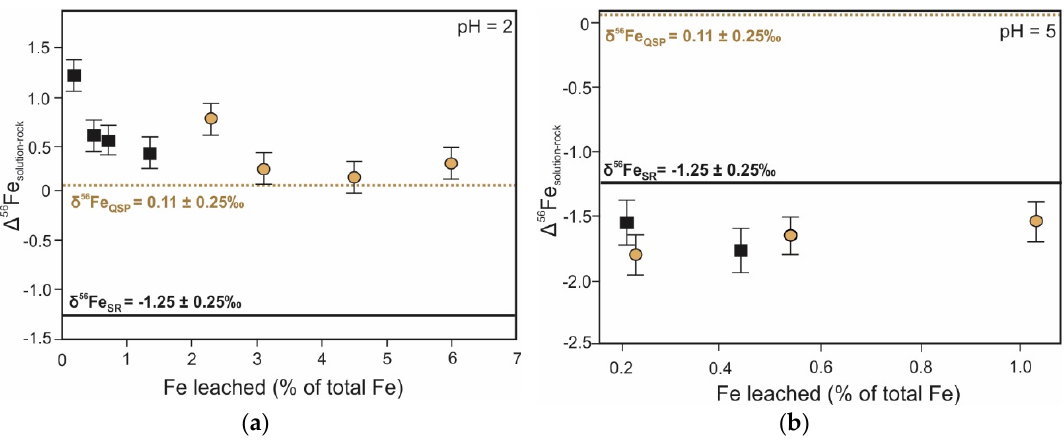
Figure 7. Fractionation of iron isotopes between solution and sulfide-rich rocks ( Δ solution-rock = δ 56 Fe solution – δ 56 Fe rock ) as a function of Fe recovery ( a ) under pH = 2 and ( b ) pH = 5 conditions during continuous batch leaching. Square symbols—leachate of sulfide rock (SR) group: pyrite, chalcopyrite, galena, sericite, pyrophyllite, anglesite, sphalerite. δ 56 Fe SR = –1.25 ± 0.25‰. Circle symbols—leachate of quartz-sericite-pyrite (QSP) group: pyrite, sericite, pyrophyllite, quartz. δ 56 Fe QSP = 0.11 ± 0.25‰. Redrawn from Fernandez and Borrok [131].